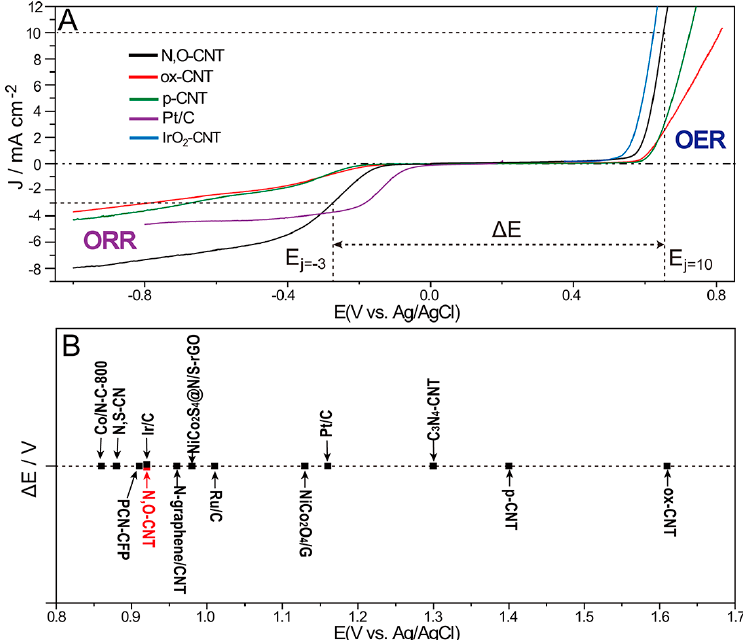
Figure 6. ( A ) The overall LSV curve of N, O-CNT in the potential range of − 1.0 to 0.8 V, ( B ) the value of Δ E of N, O-CNT and the comparison with various catalysts reported previously.